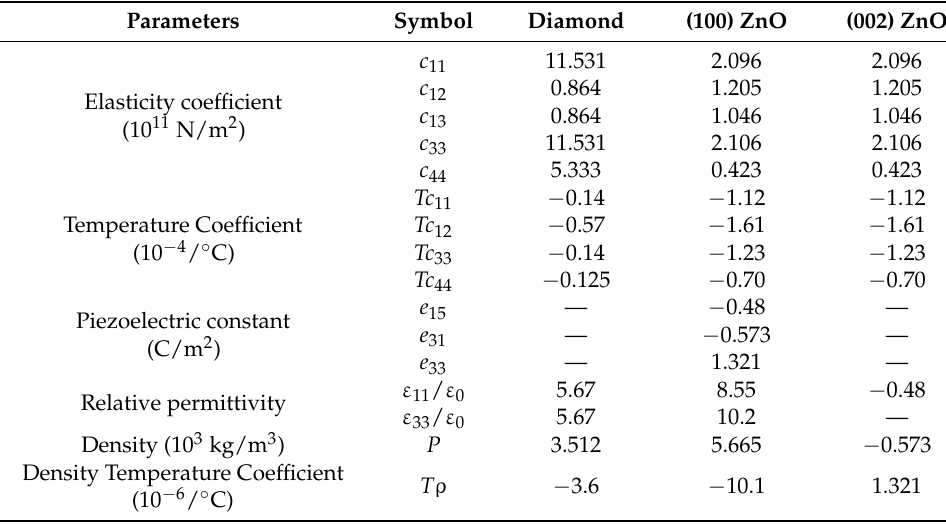
Figure 9. Phonon piezoelectric device structure of the NV center for 4 cases. Table 2. Material parameters of phonon piezoelectric device of the NV center.